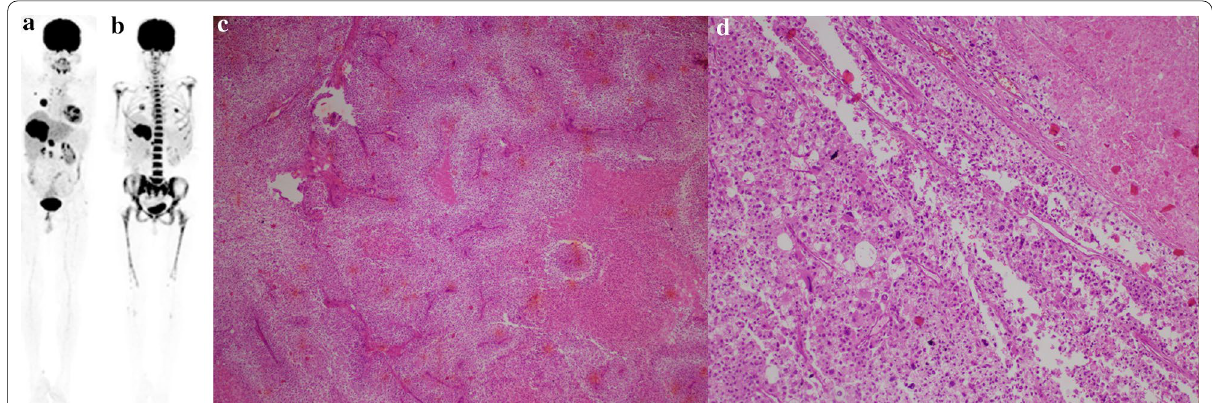
Fig. 1 a The multiple intensity projection image of the patient diagnosed as primary adrenal tumor showing right adrenal enlarged mass, abdominal metastatic lymph nodes and lung metastases. b The follow-up F-18 FDG PET/CT MIP image of the same patient two sickles after the chemotherapy showing shrinkage of the primary tumor, and no lymph node metastasis but also new developing lung metastasis and bone marrow uptake were also observed. c Cohesive tumor cell clusters with focal necrosis, HE, 40 200 .Table 1: The characteristics and results findings of the patients included in the ×